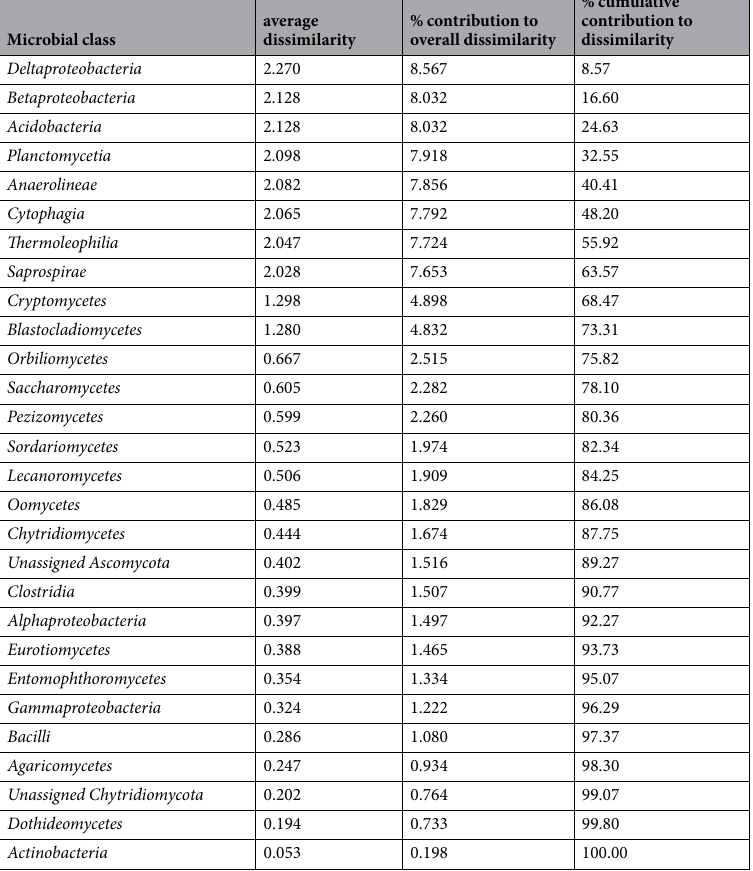
Table 2. SIMPER analysis identifies top abundant taxa that contributed most of the dissimilarities ( > 1%) between the total microbial rhizosphere communities from soil initially containing a sterile (Control)/non sterile (Vermicompost)